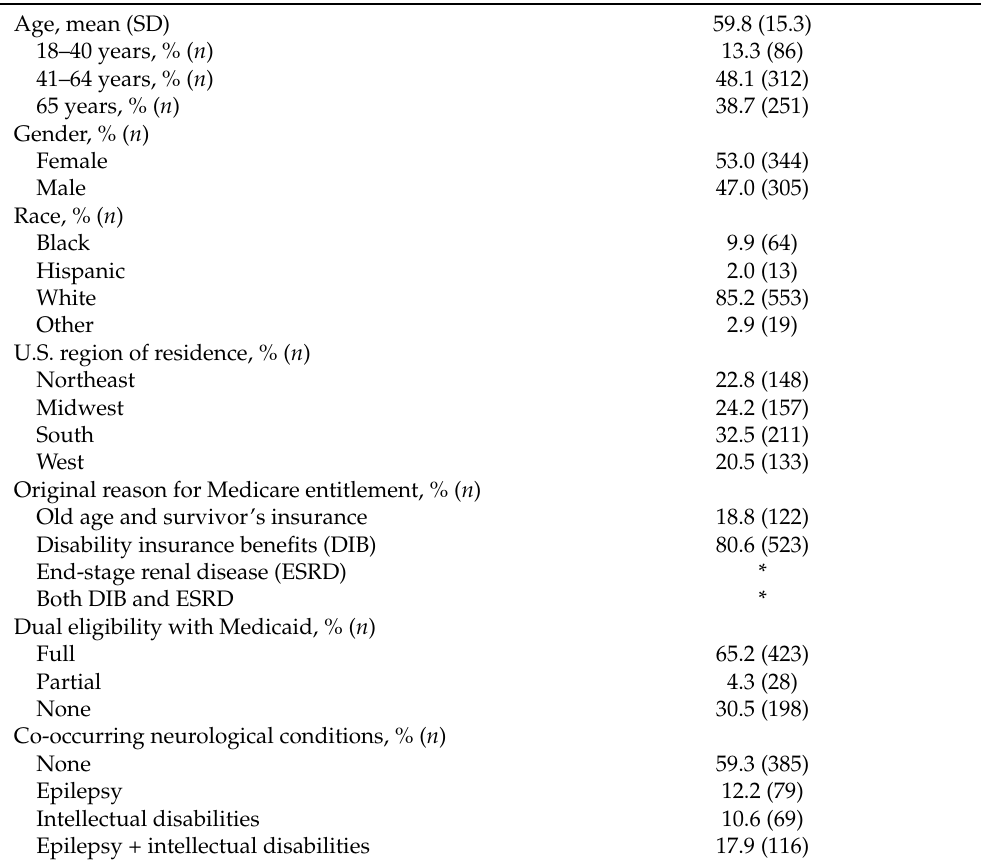
Table 1. Baseline characteristics of adults with cerebral palsy with a fragility fracture that were admitted to an acute care/rehabilitation setting ( n =